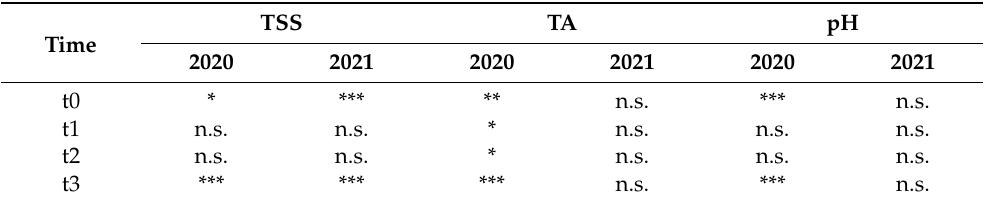
Table 3. Student (cid:48) s t -test performed between refence and predicted data for each sampling time (t0-t3) and for each year considered (2020 and 2021).